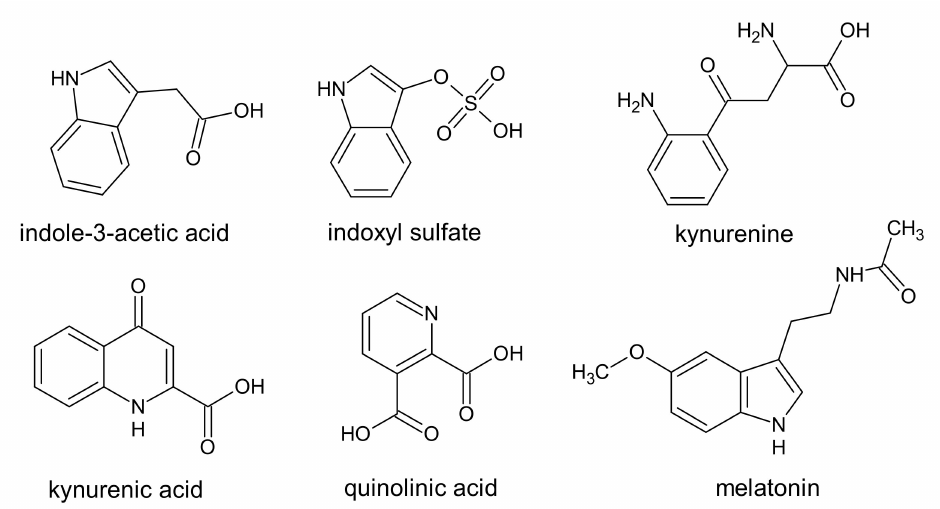
Figure 2. Chemical structure of indole, pyridine, and chinoline derivatives, classified as protein- binding uremic